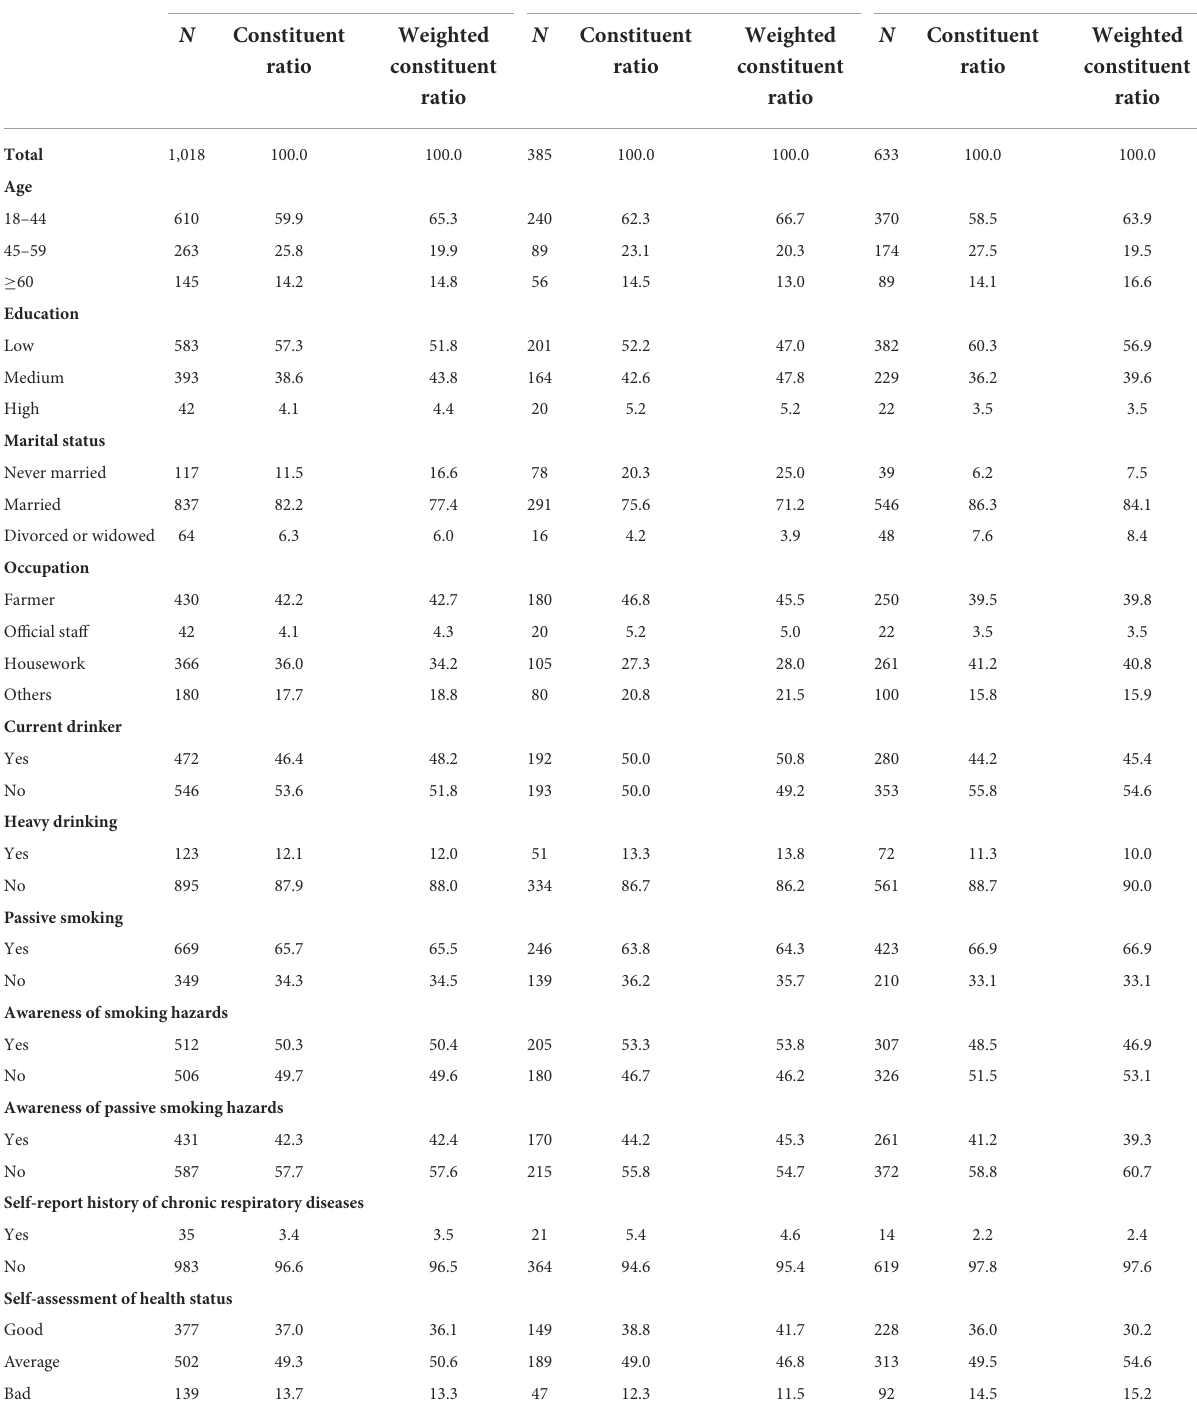
TABLE 1 Demographic characteristics of the